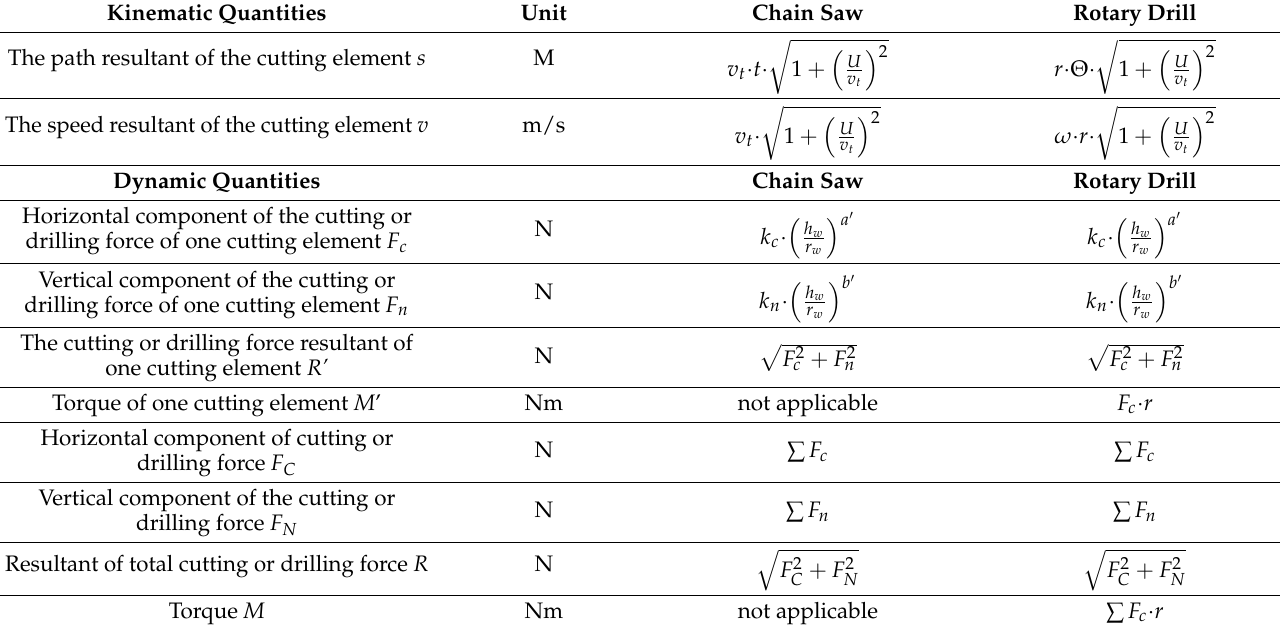
Table 1. The most important kinematic and dynamic quantities of chain saw and rotary drill. Kinematic Quantities Unit Chain Saw Rotary Drill